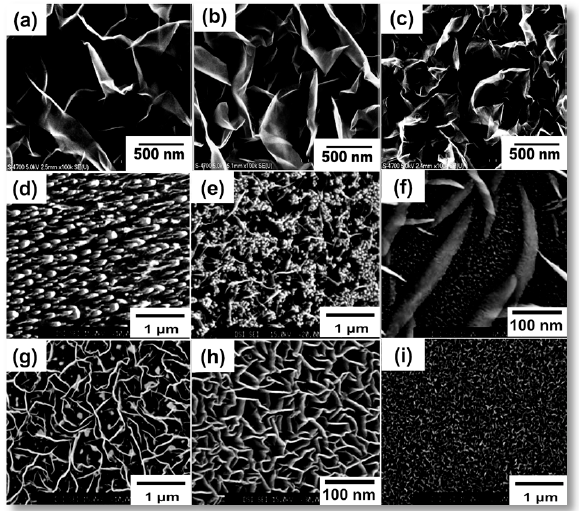
Micromachines 2018 , 9 , x Figure 4. Effect of different radical species on the growth of carbon nanowalls.